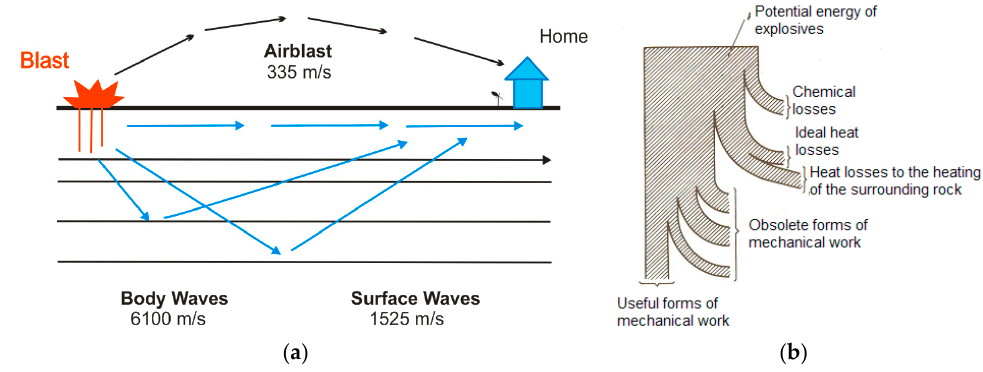
Figure 1. ( a ) Spreading of seismic and air waves during blasting; and ( b )the scheme of energy balance during blasting. during